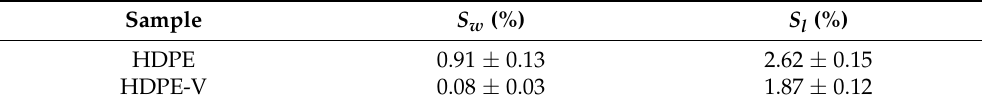
Table 3. Shrinkage perpendicular ( S w ) and parallel ( S l ) to the print orientation in the plates shown in Figure